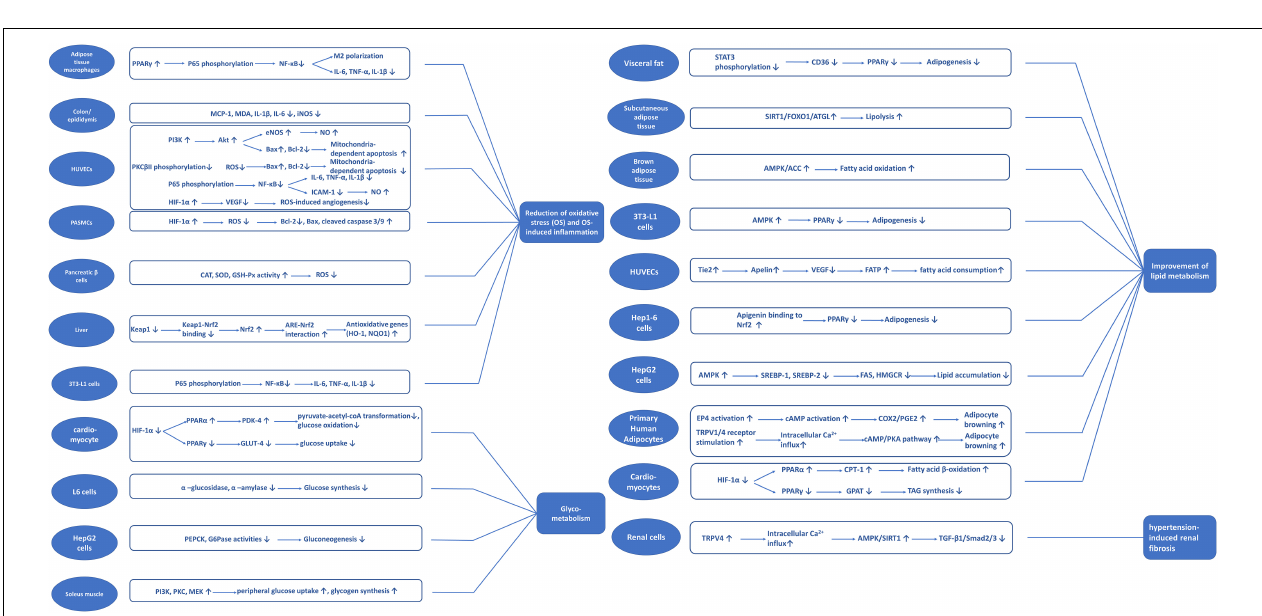
FIGURE 2 | SREBP, sterol regulatory element-binding proteins. FAS, fatty acid synthase. HMGCR, 3-Hydroxy-3-Methylglutaryl-Coenzyme A Reductase. Keap1, Kelch like ECH associated protein 1. Nrf2, NF-E2-related factor 2. (D) Potential signaling pathways of apigenin affecting cardiometabolic diseases in cardiomyocytes. HIF-1 α , hypoxia inducible factor 1 subunit alpha; CPT1, carnitine palmitoyl transferase I; PDK4, pyruvate dehydrogenase kinase 4; GPAT, glycerol-3-phosphate acyltransferase; GLUT4, glucose transporter type 4. (E) Potential signaling pathways of apigenin affecting cardiometabolic diseases in endothelial cells. PI3K, Phosphoinositide 3-kinase; Akt, protein kinase B; eNOS, endothelial nitric oxide synthase; PKC β II, protein kinase C subunit β II; ROS, reactive oxygen species; Bcl-2, B-cell lymphoma-2; Bax, Bcl2 associated X; HIF-1 α , hypoxia inducible factor 1 subunit alpha; VEGF, vascular endothelial growth factor; p65, RelA, NF- κ B component.